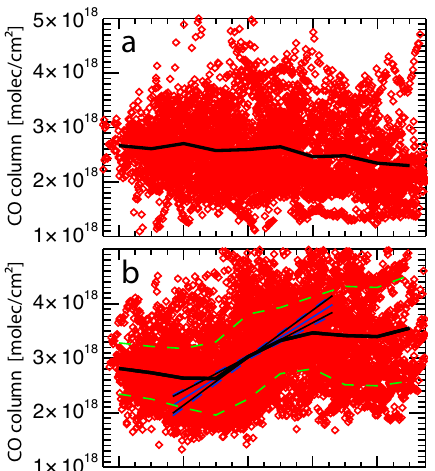
Fig. 3. The evolution of the total vertical CO column measured between 2007 and 2009 over the UNAM campus in Mexico City (19.33 ◦ N, 98.65 ◦ W) is shown as black traces. Columns measured on days with appreciable ventilation (a) display a different diur- nal pattern than on days with minimal ventilation (b). The classi- fication is done by a cluster analysis using wind information of 6 meteorological stations around the UNAM campus (see text). The average diurnal behaviour of weekdays only and with low venti- lation, together with its standard deviation (green dashed lines) is shown in plot (b). The growth-rate in the chosen interval is shown as a fitted straight line (blue) and its error is given by the 95% con- fidence interval (blue dashed hyperbola) and their asymptotes as black straight